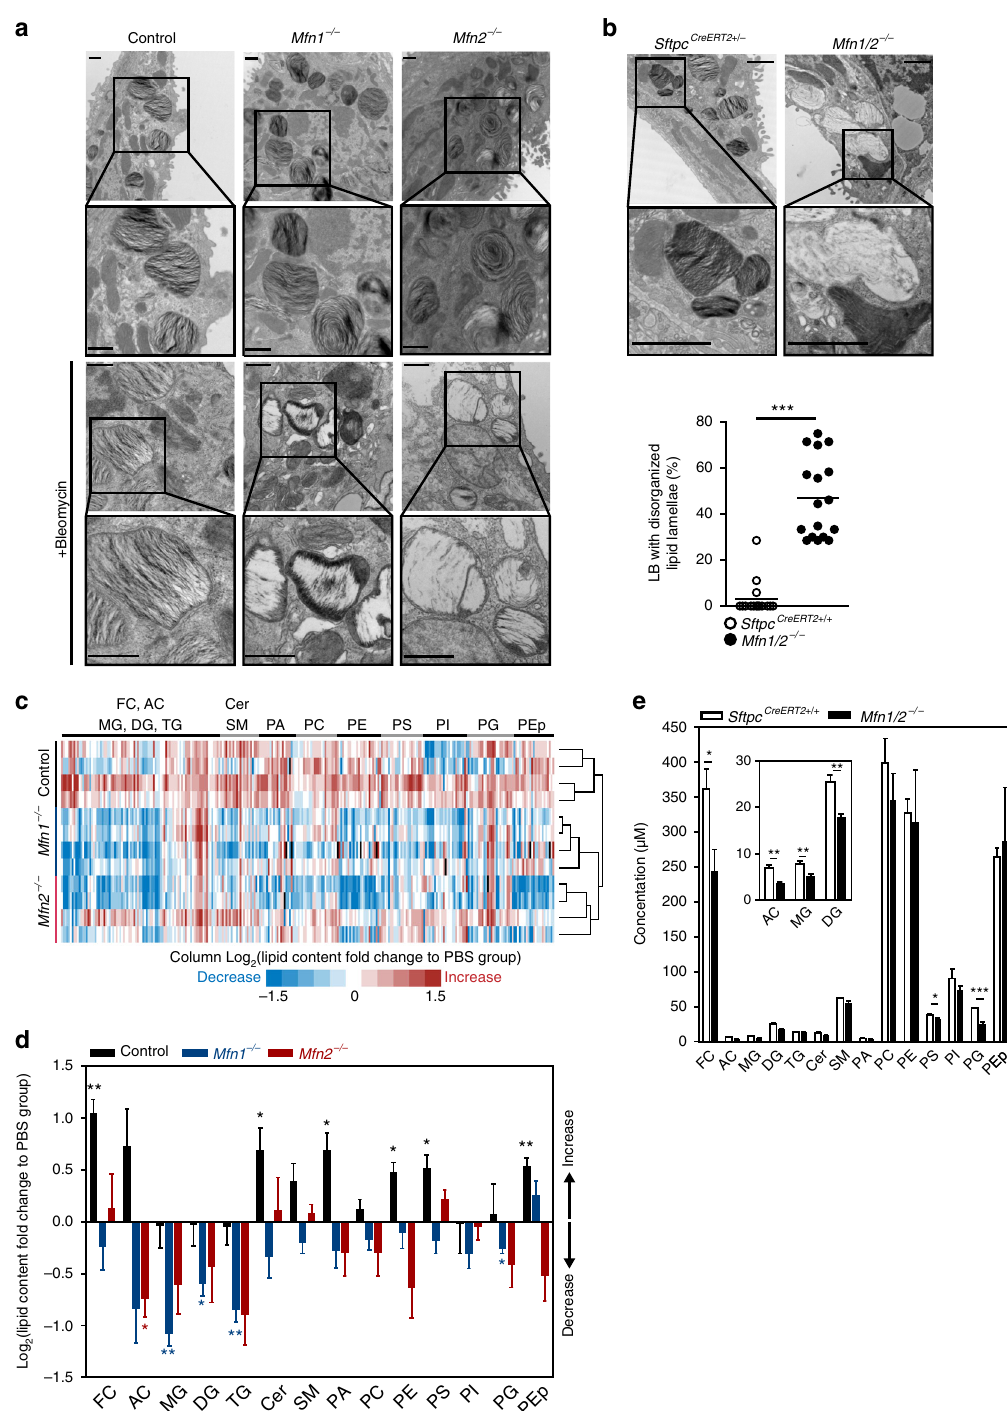
Fig. 7 MFN1 and MFN2 regulates surfactant lipid synthesis in AEC2 cells. a , b Representative TEM images of lamellar bodies (LB) in control, Mfn1- and Mfn2- de fi cient AEC2 cells at baseline (×25,000; n = 3 mice per group) and 8 days after bleomycin treatment (×50,000; n = 2 mice per group) (scale bar 500 nm) ( a ) and in Sftpc CreERT2 + / − and Mfn1/2 − / − AEC2 cells (×25,000; n = 3 mice per group; scale bar 1 μ m) ( b , left panel). Quanti fi cation of the percentage of LB with disorganized lipid membranes in AEC2 cells by TEM image analysis (×12,000) ( b , right panel). Each dot represents one AEC2 cell ( Sftpc CreERT2 + / − AEC2 cells n = 15 from 3 mice, Mfn1/2 − / − AEC2 cells n = 17 from 2 mice; *** p < 0.001, vs. control by unpaired Student ’ s t test). c , d Heat map ( c ) and bar graph ( d ) of differential changes of speci fi c lipid contents in control, Mfn1 − / − and Mfn2 − / − AEC2 cells ( n = 4 biologically independent samples per group) 8 days after bleomycin treatment. The fold-changes of speci fi c lipids in AEC2 cells after bleomycin treatment relative to those after PBS treatment ( n = 3 biologically independent samples per group) were calculated and log-transformed (base 2) ( d , * p < 0.05, ** p < 0.01, calculated fold change vs. 1 by unpaired Student ’ s t test). e Lipidomic analysis in Sftpc CreERT2 + / + and Mfn1/2 − / − AEC2 cells ( n = 4 mice per group; * p < 0.05, ** p < 0.01, *** p < 0.001, vs. Sftpc CreERT2 + / + AEC2 cells by unpaired Student ’ s t test). Data are presented as mean±s.e.m. ( d , e ). Source data ( b – e ) are provided as